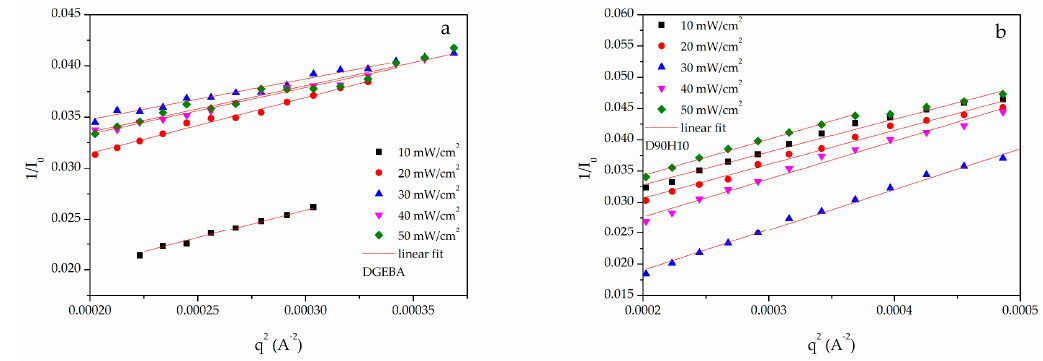
Figure 10. Zimm plot for ( a ) DGEBA and ( b ) D90H10 thermosets cured at various UV intensity.